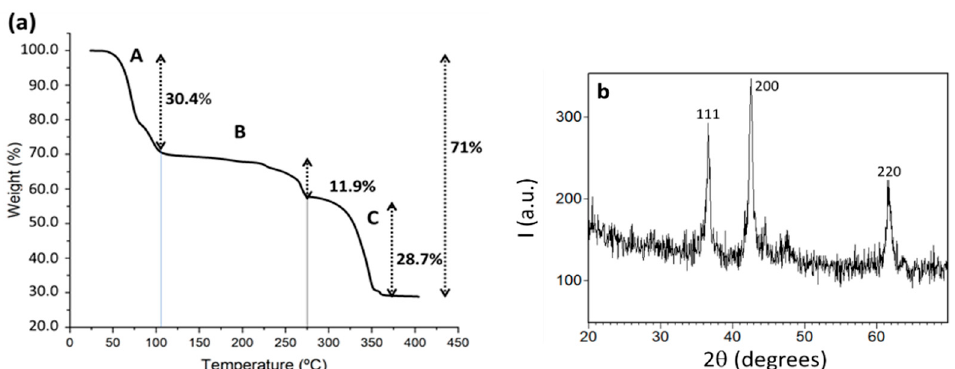
Figure 2. ( a ) TGA plot of the decomposition of commercial Co(CH 3 COO) 2 ·4H 2 O under N 2 atmosphere. Step A : from RT up to 110 °C; Step B : from 110 to 275 °C; Step C : from 275 to 400 °C. ( b ) XRD pattern of the final product of the TGA analysis. All the intense maxima correspond to the CoO rocksalt (PDF 00-048-1719).